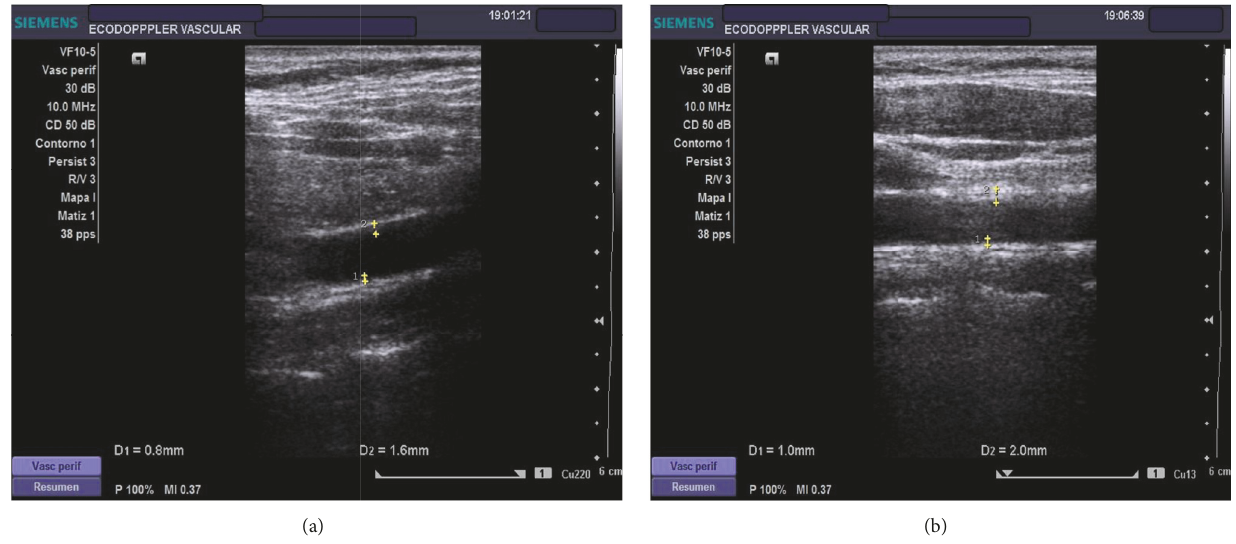
Figure 2: The vascular ultrasound study in our patient showed atherogenic plates: (a) 1.6 mm in RCCA (right common carotid artery) and (b) 2 mm in LCCA (left common carotid artery).